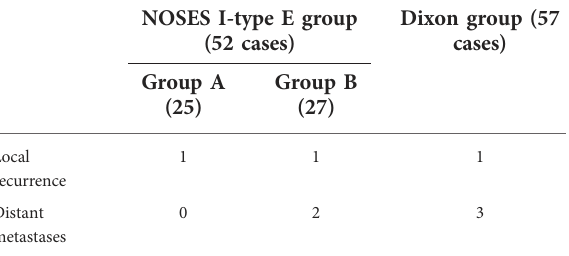
TABLE 7 local recurrence and metastasis in the four groups at 3 years follow-up.